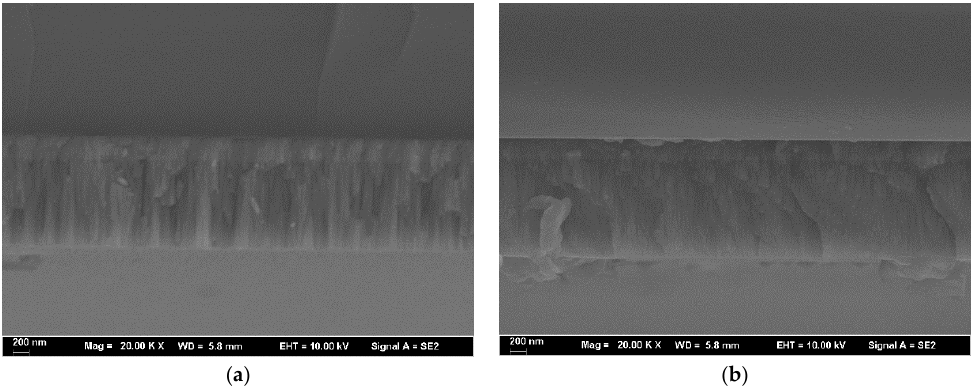
Figure 2. The cross ‐ sectional SEM images of Cr ‐ Ti ‐ B ‐ N films with various Ti and B contents: ( a ) CrN; ( b ) Cr 33.4 Ti 5.3 B 7.6 N 53.7 .